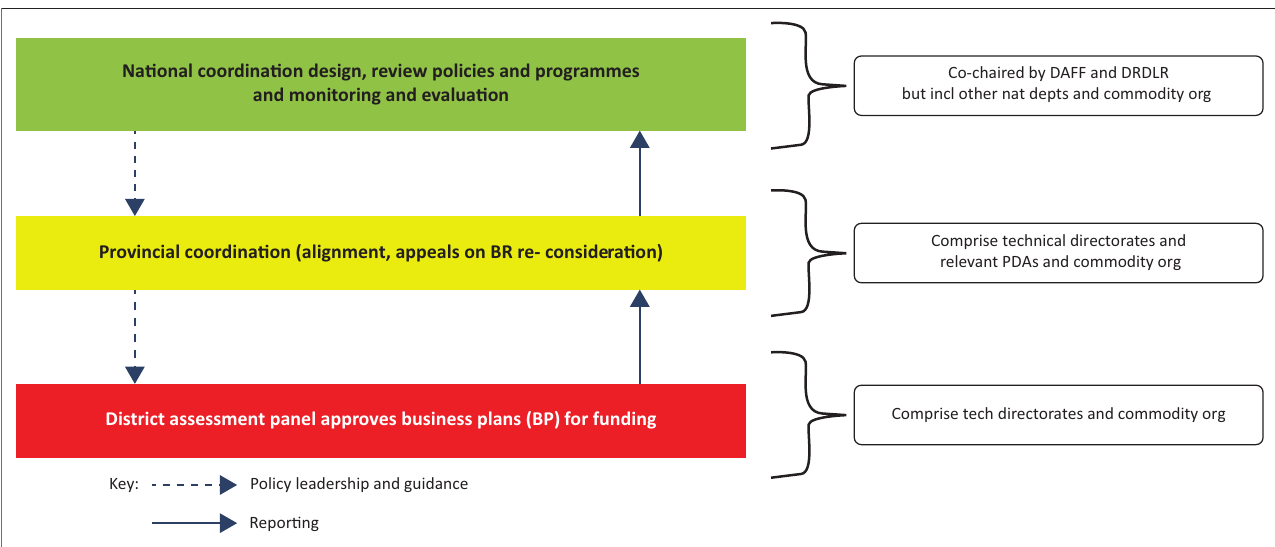
FIGURE 6: Institutional mechanism for implementing the Policy on Comprehensive Producer Development